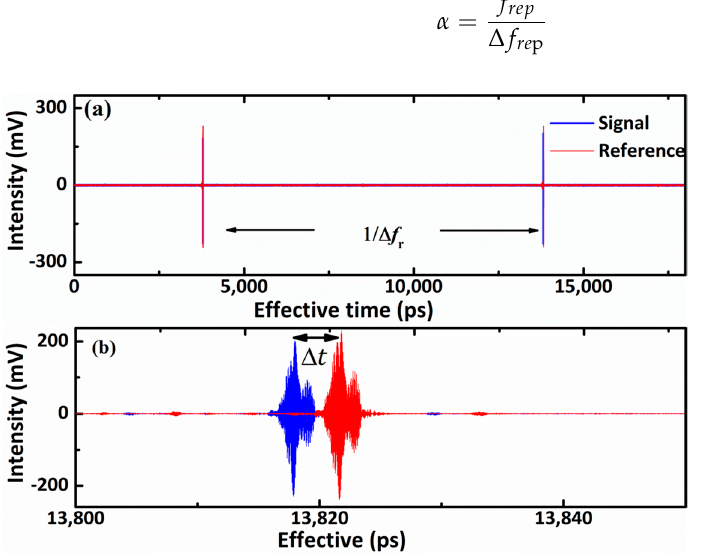
Figure 2. Two interferograms in the time domain. ( a ) Captured reference interferogram (red) and signal interferogram (blue). ( b ) Magnified view of interferograms.